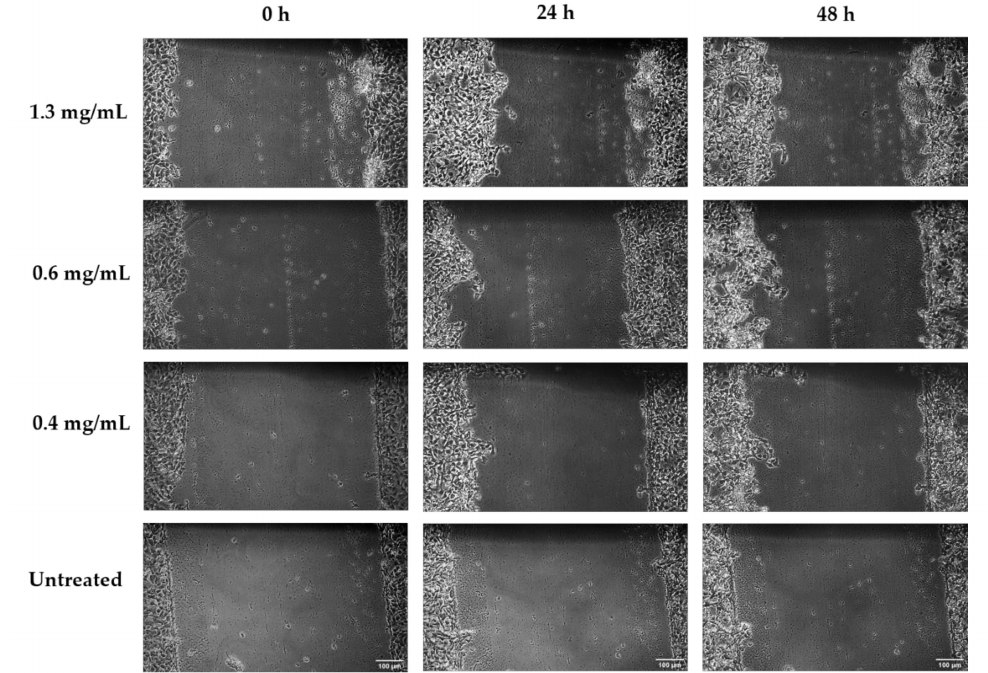
Figure 4. Microscopic photos of wound gaps in HaCaT cells introduced by the scratch technique after treatment with Aloe muth-muth gel at 1.3 mg / mL, 0.6 mg / mL, and 0.4 mg / mL, compared to an untreated control, at 0 h, 24 h, and 48 h. Images were captured at 10 × magnification and the scale bars indicate 100 µ